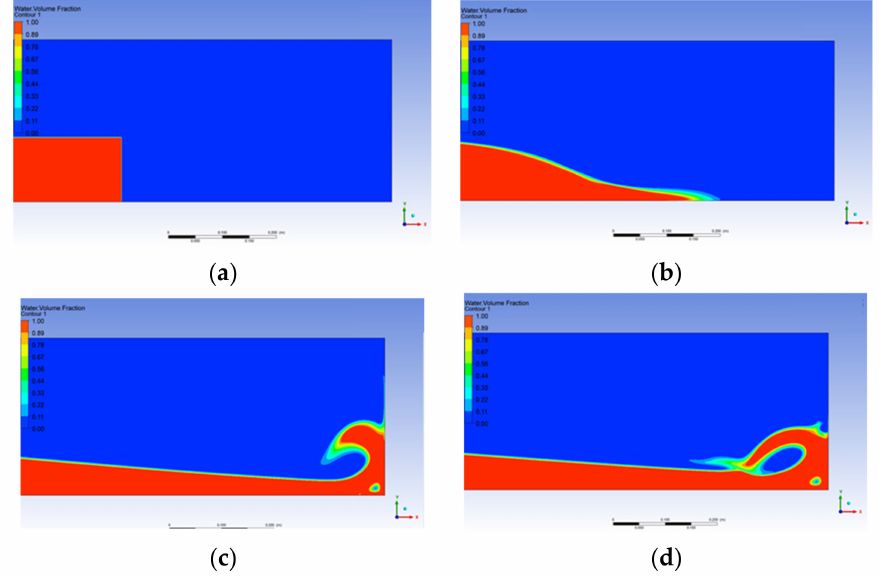
Figure 2. Free surface history of dam breaking problem based on water volume fraction: ( a ) 0.0 s; ( b ) 0.2 s; ( c ) 0.7 s; ( d ) 0.9